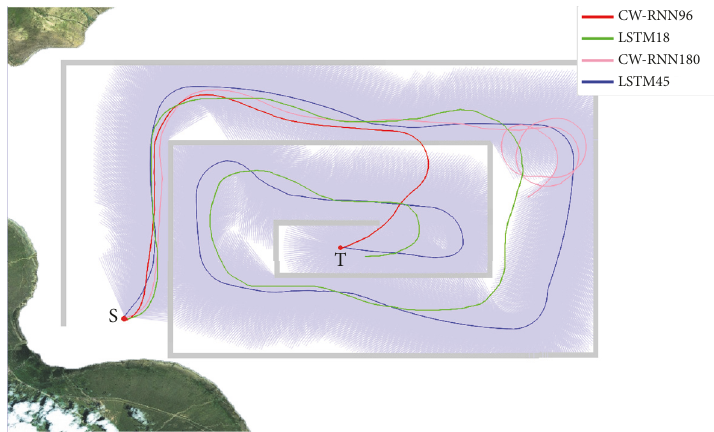
Figure 16: Online planning results of several obstacle avoidance algorithms of UUV in simulation test case 4.